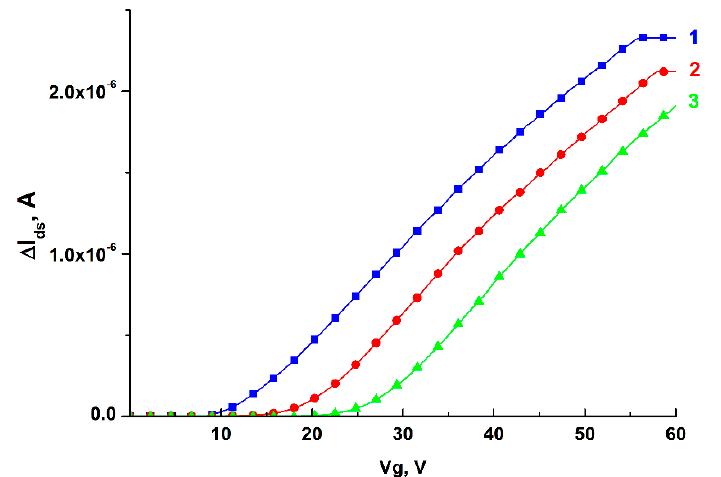
Figure 3. Monitoring the efficiency of functionalization of the n-type nanochip surface. The cur- rent-voltage characteristics of the nanoribbon are presented before the onset of functionalization with o-DNA probes (1), after the stage of chemical modification of the nanochip (2), and upon completion of the sensitization stage (3).